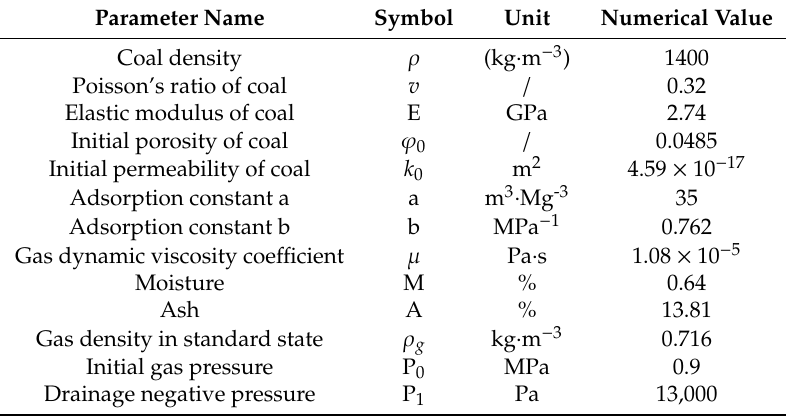
Table 1. Material parameters of gas-bearing coal.